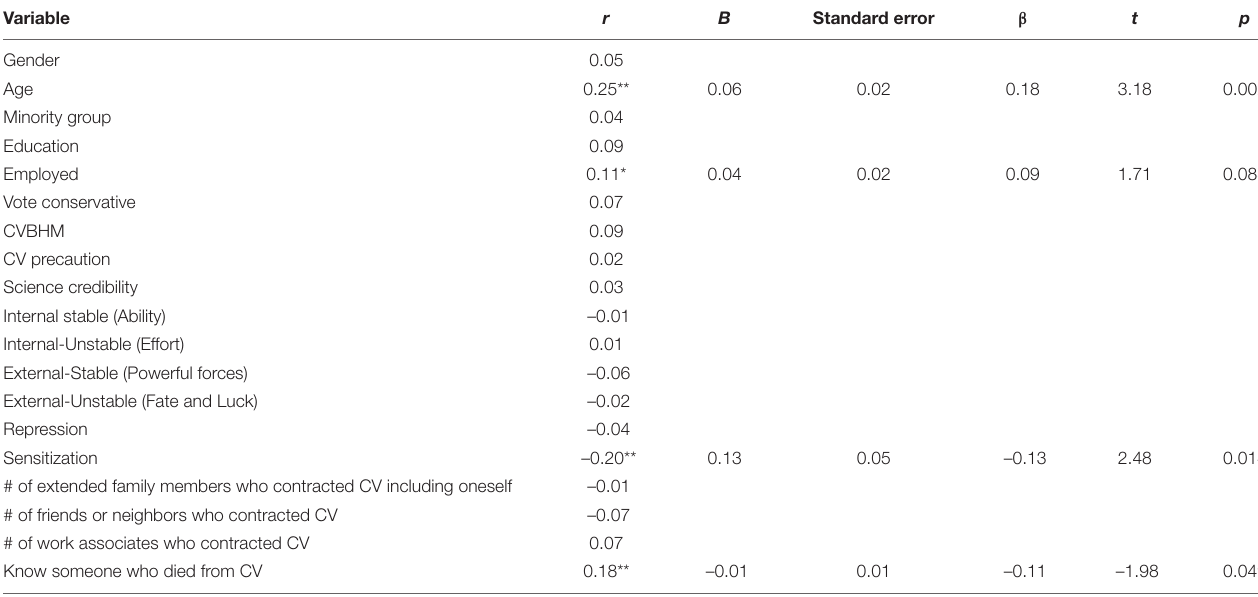
TABLE 10 | Correlations and multiple regression of demographic, attributional, and coping variables with personal versus prosocial motives for volunteering to help deliver COVID-19 Vx (Study 3). Variable r